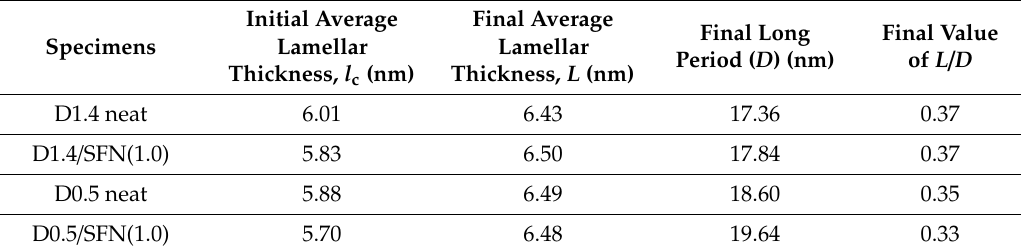
Table 3. SAXS results for the isothermal crystallization at 110 ◦ C.